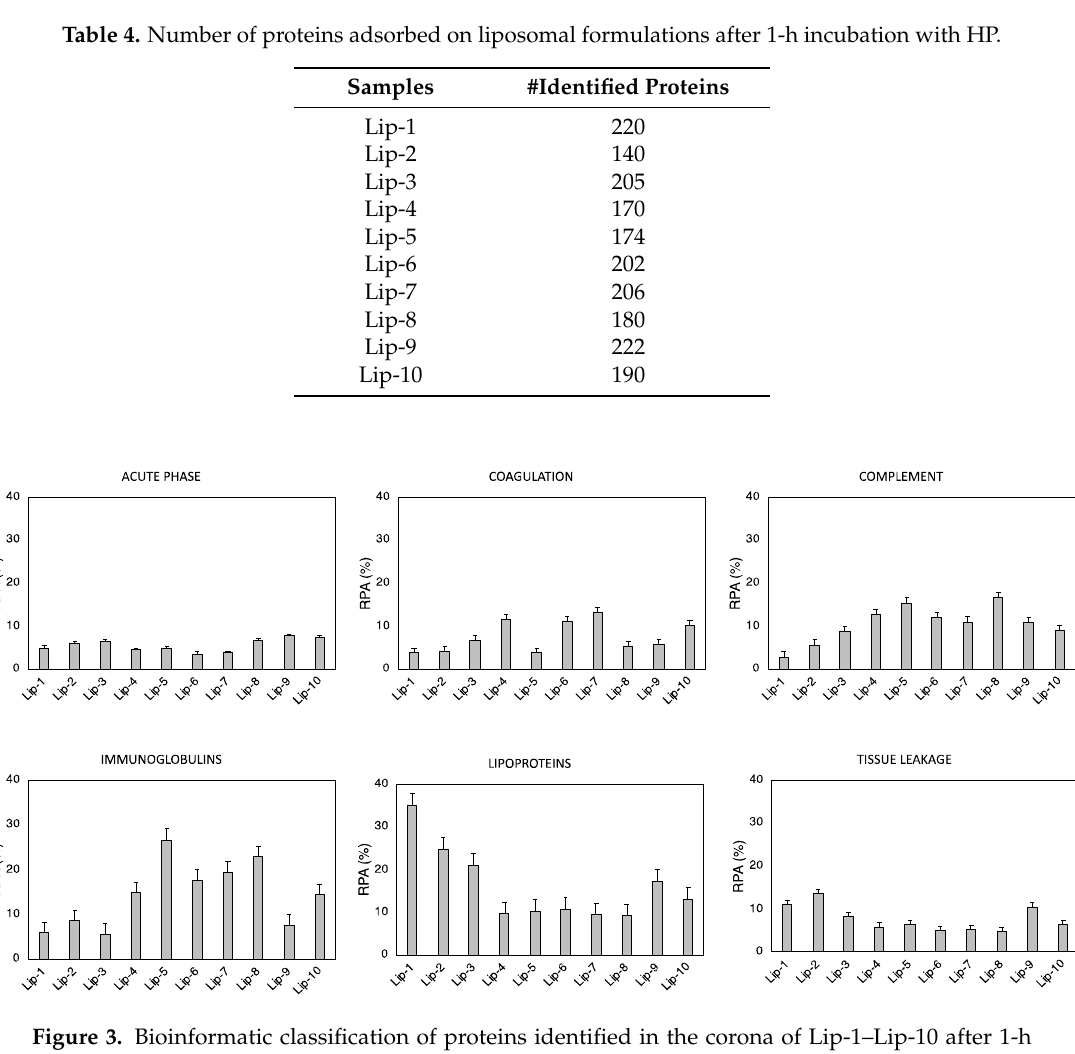
Figure 3. Bioinformatic classification of proteins identified in the corona of Lip-1–Lip-10 after 1-h exposure to HP. The relative protein abundances (RPAs) of total proteins are shown.